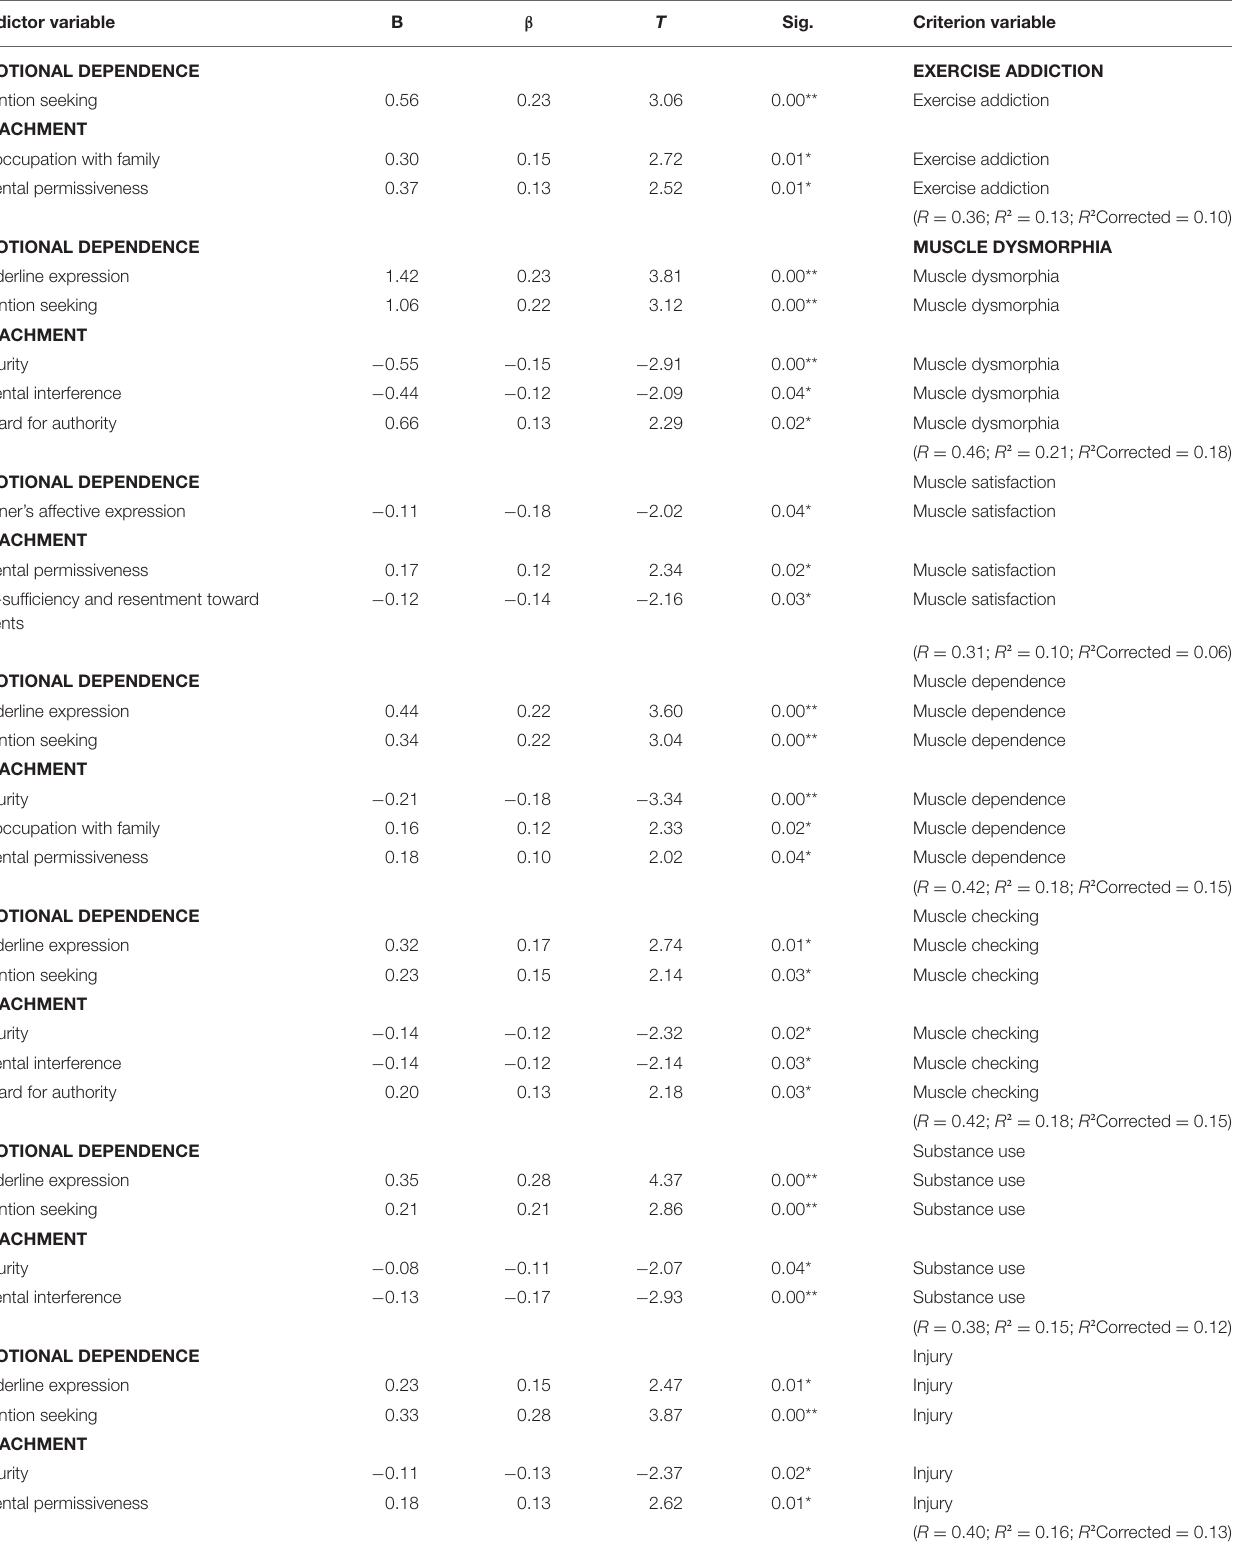
TABLE 4 | The predictive role of emotional dependence and attachment dimensions in exercise addiction and muscle dysmorphia. Predictor variable B β T